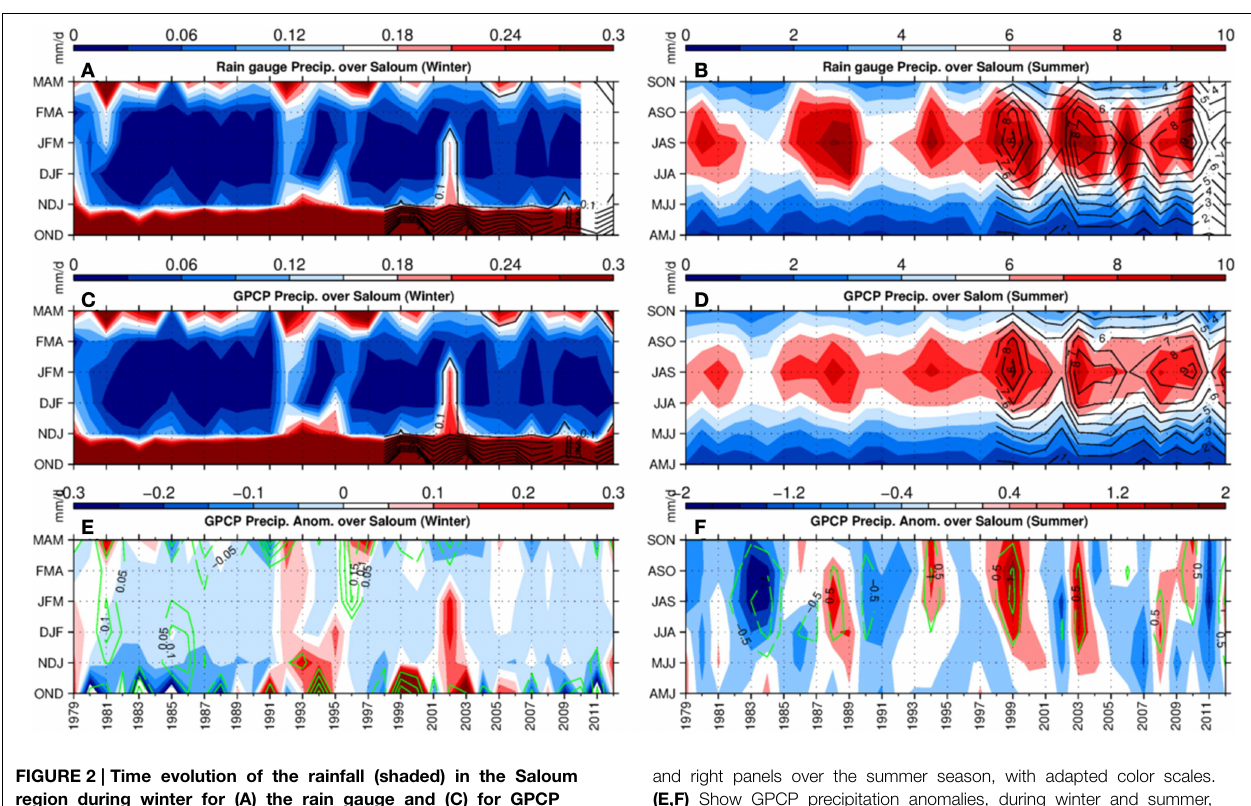
FIGURE 2 | Time evolution of the rainfall (shaded) in the Saloum region during winter for (A) the rain gauge and (C) for GPCP precipitation and during summer for (B) the rain gauge and (D) for GPCP precipitation. TRMM precipitations are shown in contours in all four panels. The vertical axis of the plot shows the different seasons of the year. Left Panels are centered over the winter season